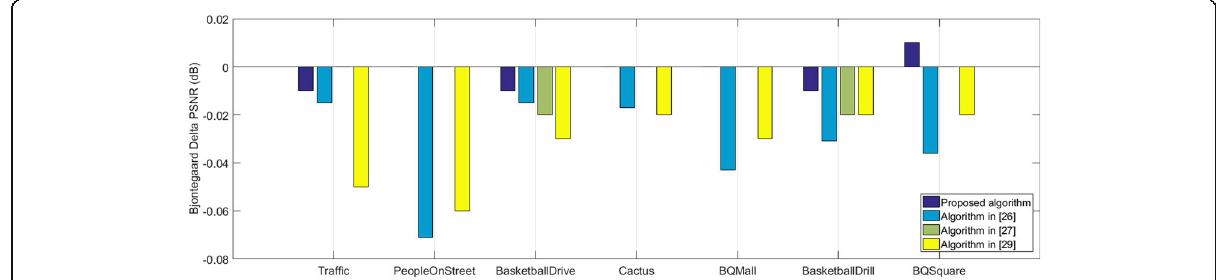
Fig. 12 PSNR change comparison of the proposed algorithm and the algorithms in [26, 27, 29] in RA case (the blank is zero that means no change)